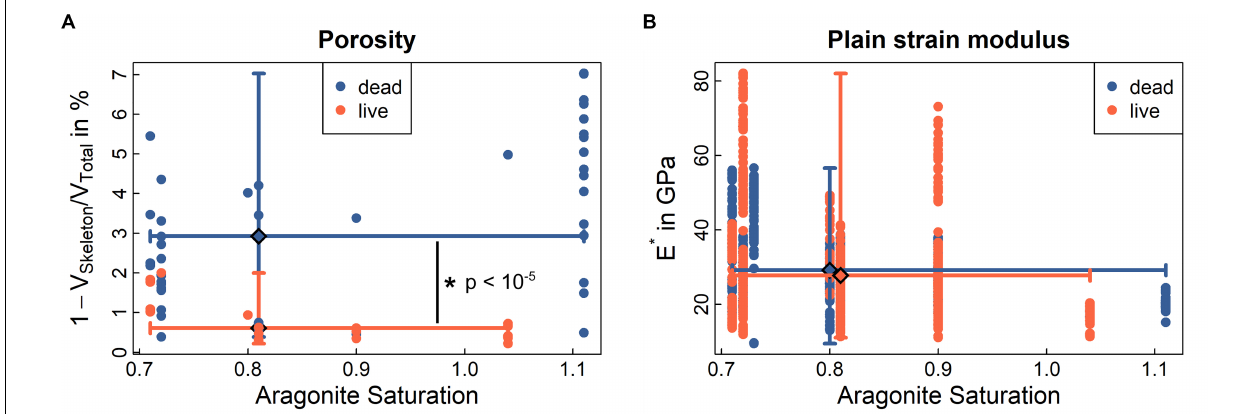
FIGURE 5 | Porosity and mechanics of CINMS Lophelia pertusa. The Figure shows (A) porosity of the skeletal volume, and (B) stiffness (plain strain modulus) of the skeletal material. Data represented as medians with min/max error bars for both axes at respective median (large diamond). Significant differences between live and dead samples are indicated by *. See also Supplementary Figure 4 for Raman crystallinity, electron back scatter diffractions and other material chemistry of samples. Solid lines indicate ranges (min-max) around the median (large diamond) for ordinate and abscissa for live and dead samples,